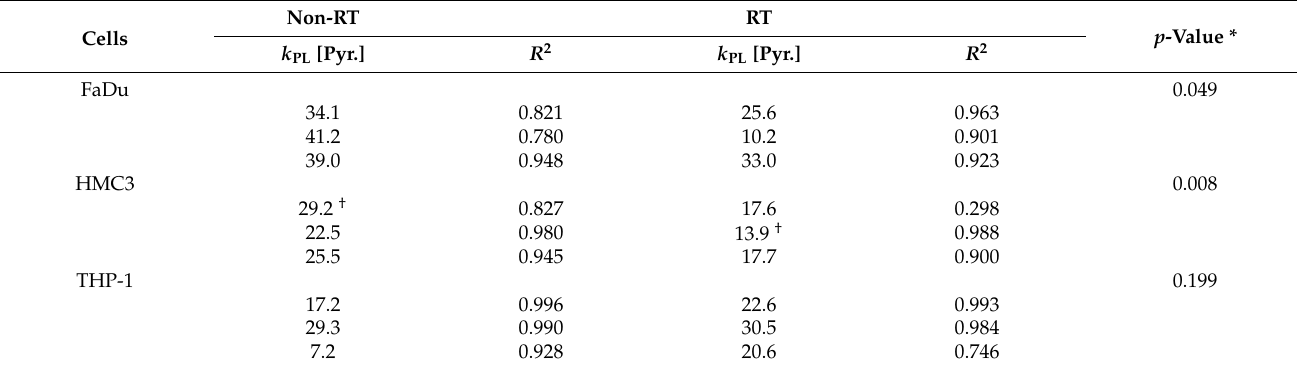
Table 1. Conversion rates ( k PL [Pyr.]) of hyperpolarized [1- 13 C]pyruvate to [1- 13 C]lactate in cells. Cells